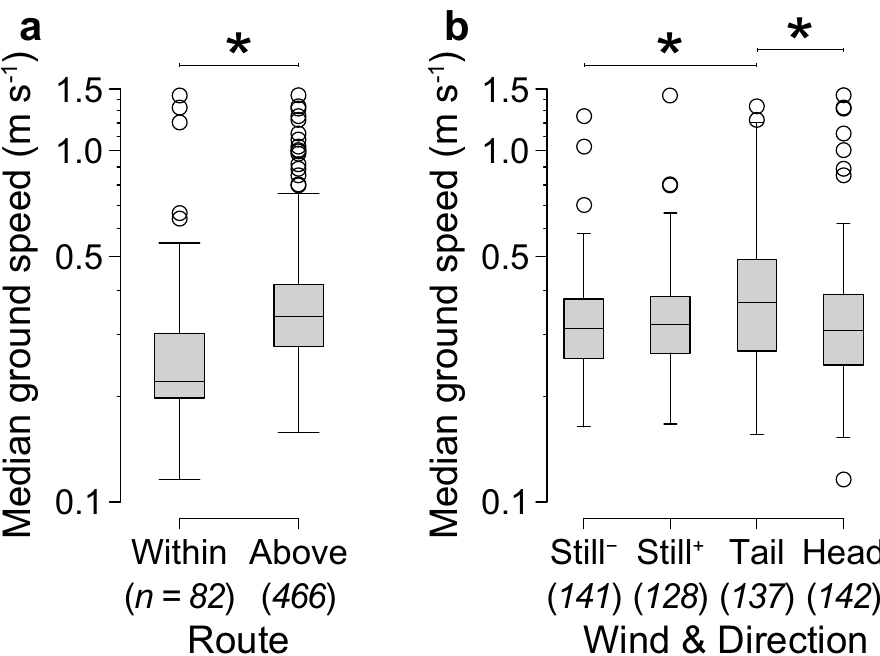
Fig 4. Effects of route and wind on ground speeds of bees transiting the obstacle field. (a) Median ground speeds were significantly higher above versus within the obstacle fields. (b) Median ground speeds were significantly higher in tailwinds than in headwinds and still air (down-tunnel direction only). “Still - ” indicates down-tunnel flights in still air and “Still + ” indicates up-tunnel flights in still air. Lines with asterisks indicate statistically different groups based on a linear mixed-effect model with Tukey post hoc comparisons ( � P < 0.05). Italicized numbers below the x-axes labels show the sample size (number of flights) for each group.